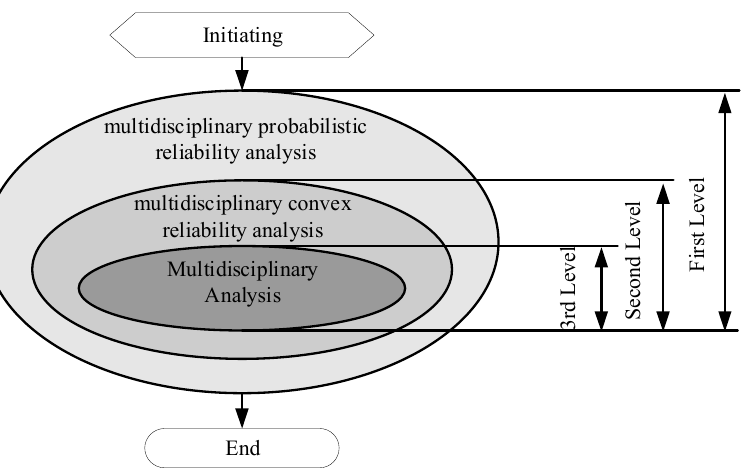
This equation can obtain the value of coupling state variables in the following way. This section also takes a complex system consisting of three coupling disciplines as an example (as shown in Figure 4) and explain its MDA process in detail.